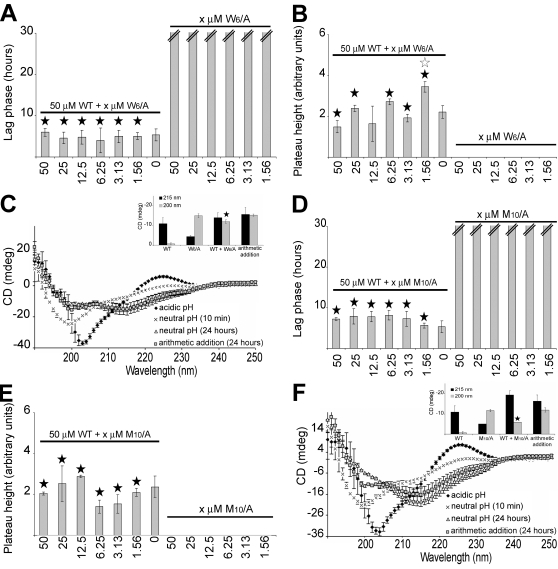
Effect of the mutant peptides W6/A and M10/A on AChE586-599 fibrilization.Varying concentrations of the mutant peptides were incubated with 165 µM ThT, with or without 50 µM AChE586-599. Changes in ThT fluorescence were measured and plotted as the lag phase of fibrilization (A and D) and the plateau height (B and E). The double bar in A and D indicates the absence of fibrilization (i.e.an indeterminably long lag phase). Far UV spectra (250 to 190 nm) before and after pH neutralization (50 mM NaH2PO4, pH 7.2) of 75 µM AChE586-599 with 75 µM mutant peptide (C and F). The insets show the mean residue ellipticity at 200 nm (random coil) and 215 nm (β-sheet) for 75 µM AChE586-599, 75 µM mutant peptide, 75 µM AChE586-599 with 75 µM mutant peptide, and the arithmetic addition of AChE586-599 to the mutant. (A and B) The mutant peptide W6/A does not affect either the lag phase (A, a black star signifies p<0.002 when compared to W6/A at the equivalent concentration) or the plateau height of AChE586-599 (B, a black star signifies p<0.045 when compared to W6/A at the equivalent concentration; a white star signifies p<0.05 when compared to AChE586-599). (C) The mutant peptide W6/A interacts with AChE586-599. A black star signifies p<0.014 when compared to the arithmetic addition of 75 µM W6/A mutant to 75 µM AChE586-599. (D and E) The mutant peptide M10/A does not affect either the lag phase (D, a black star signifies p<0.0007 when compared to M10/A at the equivalent concentration) or the plateau height of AChE586-599 (E, a black star signifies p<0.045 when compared to M10/A at the equivalent concentration). (F) The mutant peptide M10/A interacts with AChE586-599. A black star signifies p<0.01 when compared to the arithmetic addition of 75 µM M10/A mutant and 75 µM AChE586-599.